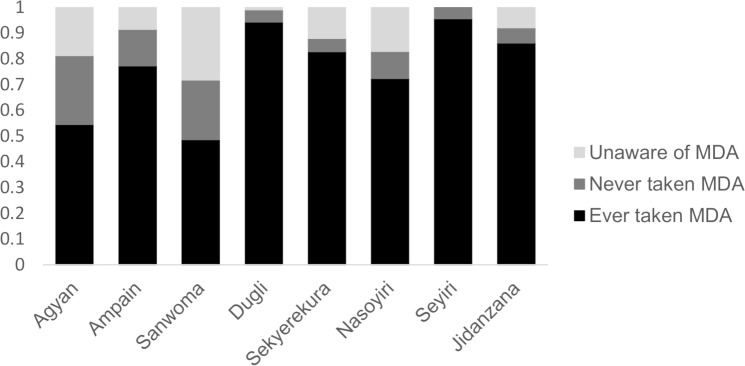
MDA coverage by village.Study participants were first asked whether they were aware of the filariasis drug distribution. If they answered yes they were asked whether they had ever taken part in the MDA and the number of rounds they recalled participating in. The median number of rounds reported was as follows: Agyan (8), Ampain (4), Dugli (3), Jidanzana (4), Nasoyiri (2), Sanwoma (3), Sekyerekura (3), Seyiri (8).